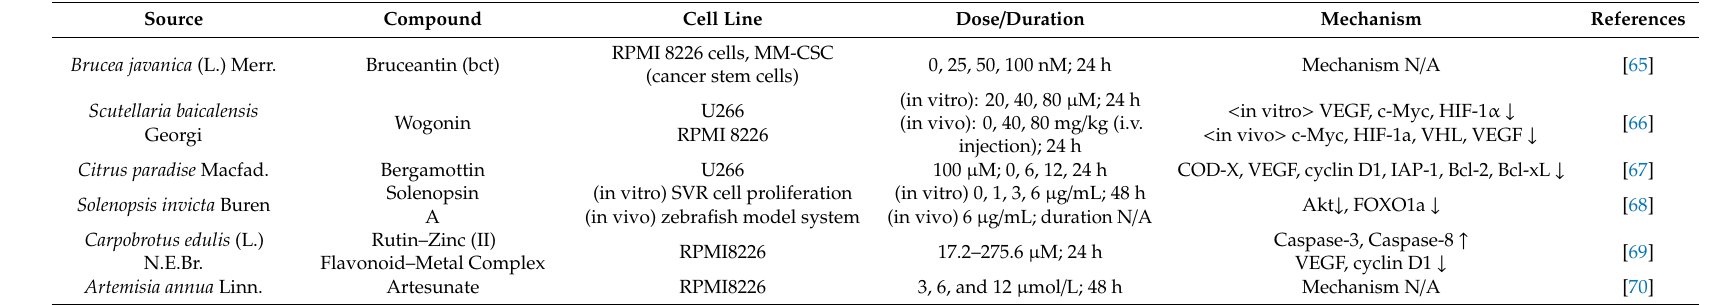
Table 5. Angiogenesis inhibiting natural